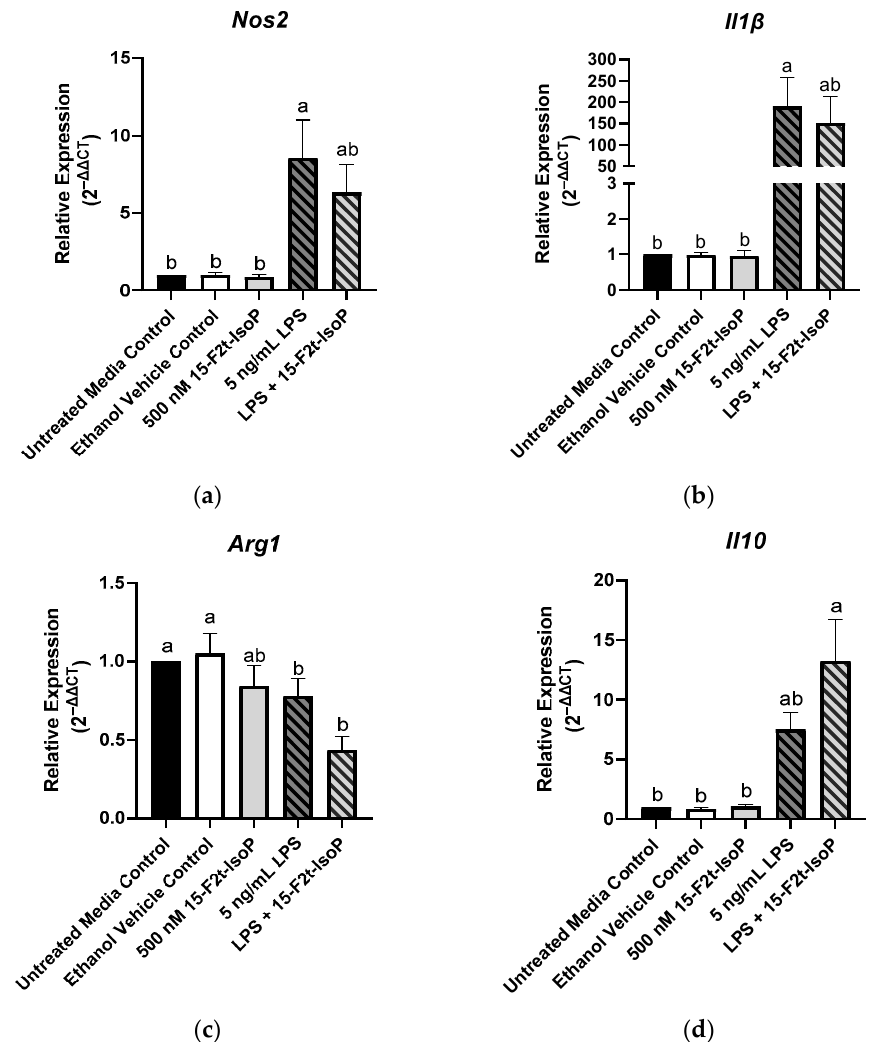
Figure 4. Relative gene expression of common macrophage phenotype markers is shifted in RAW 264.7 cells ( n = 7) treated with endotoxin and 15-F 2t -isoprostane: ( a ) nitric oxide synthase 2 ( Nos2 ), ( b ) interleukin ( Il ) 1 β , ( c ) arginase 1 ( Arg1 ), ( d ) Il10 . Statistical analyses included a one-way ANOVA with Tukey’s HSD posthoc test. a,b Different superscripts are different ( p < 0.05). LPS—lipopolysaccharide; IsoP—isoprostane.